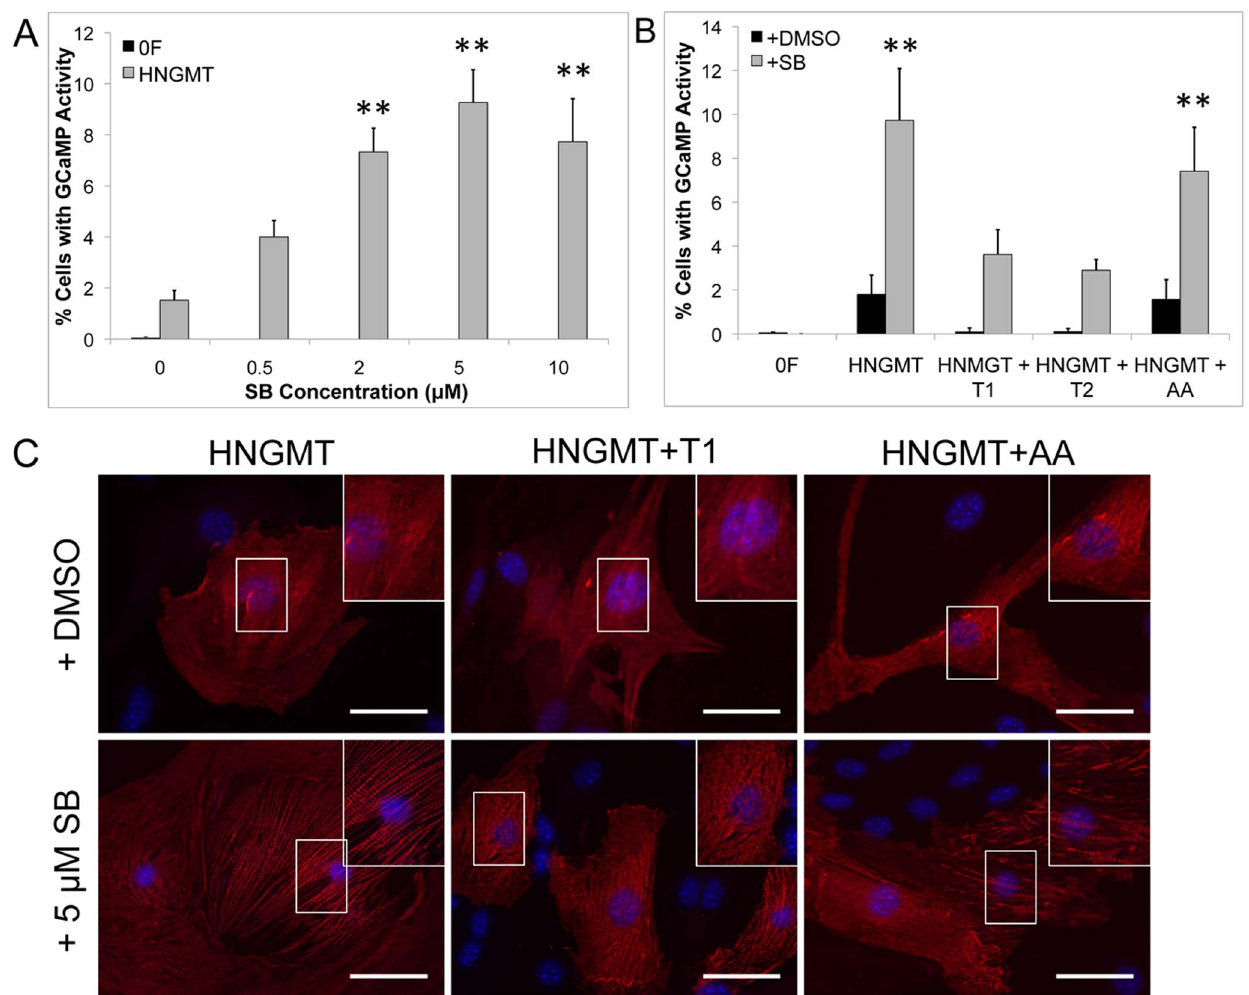
Figure 4. Direct conversion of adult mouse cardiac fibroblasts (CFs) to iCMs. Conversion efficiency to iCMs increases in yield with increasing concentration of SB (A). Direct conversion of CFs to iCMs is reduced with addition of TGF b 1 (black, HNGMT + T1) and TGF b 2 (black, HNGMT + T2) to the culture medium, but not Activin A (black, HNGMT + AA). Addition of SB (grey) increases the yield of iCMs generated in the presence of TGF b 1 (grey, HNGMT + T1) and TGF b 2 (grey, HNGMT + T2 and Activin A (grey, HNGMT + AA) (B). Immunostaining for a Actinin (red) and DAPI (blue) demonstrate increased sarcomeric structure with SB treatment for HNGMT + T1 (C). ** indicates p , 0.01 compared to HNGMT + DMSO control.